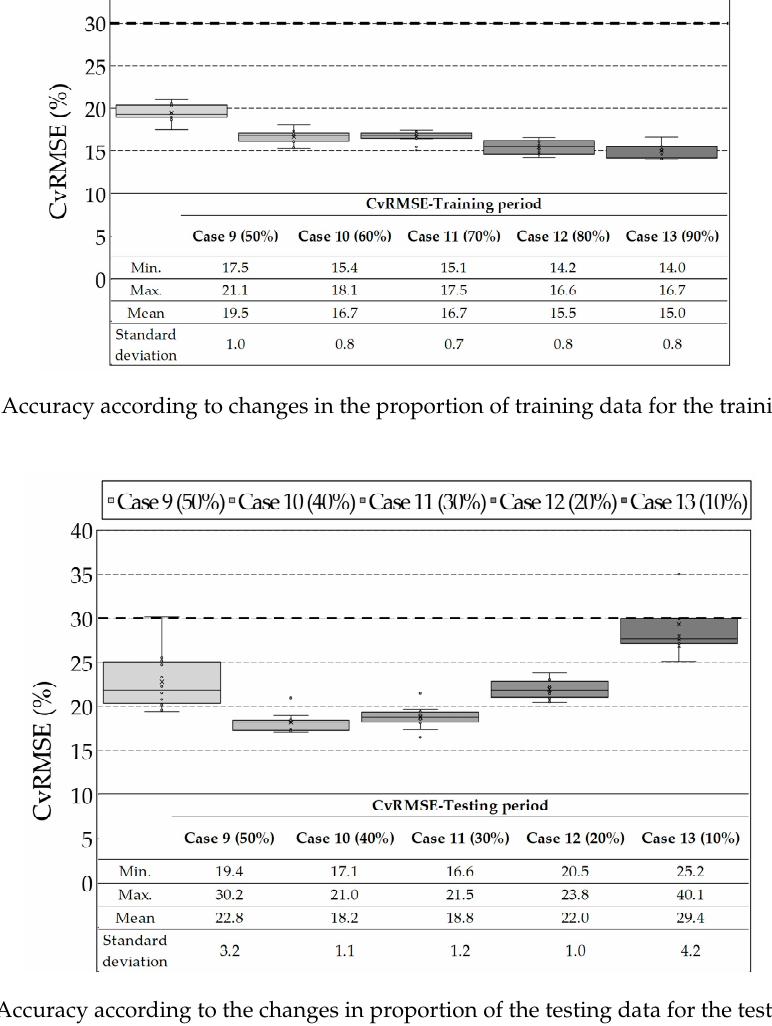
Energies 2019 , 12 , x FOR PEER REVIEW 9 of 13